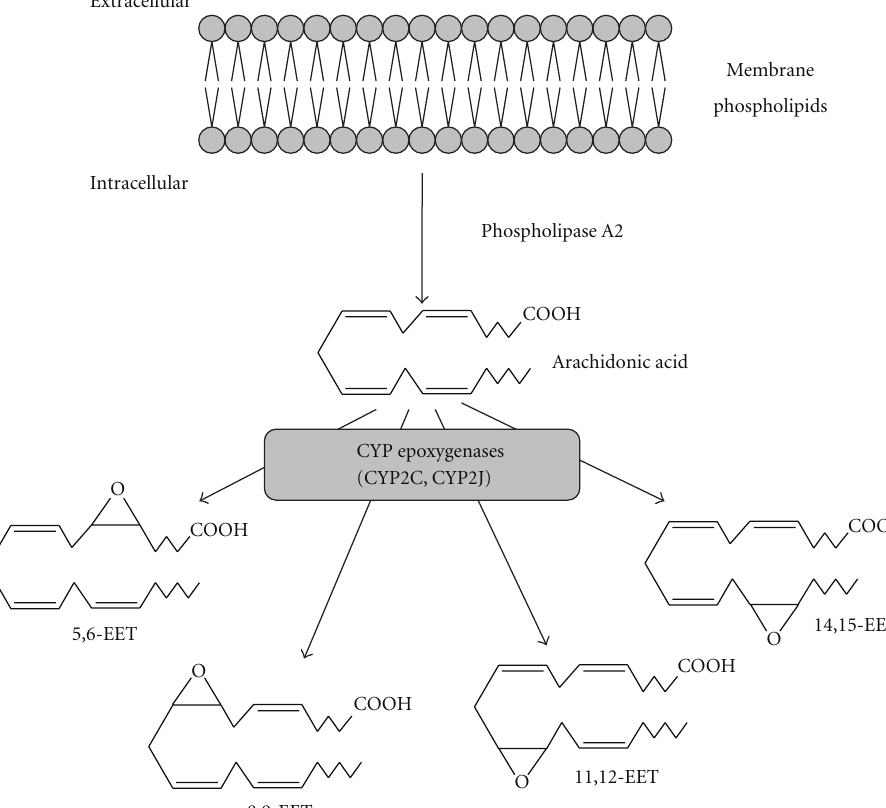
Figure 1: Conversion of arachidonic acid to EETs. Arachidonic acid is released from membrane phospholipids by phospholipase A2. CYP epoxygenases (CYP2C and CYP2J) convert AA into four regioisomeric EETs.